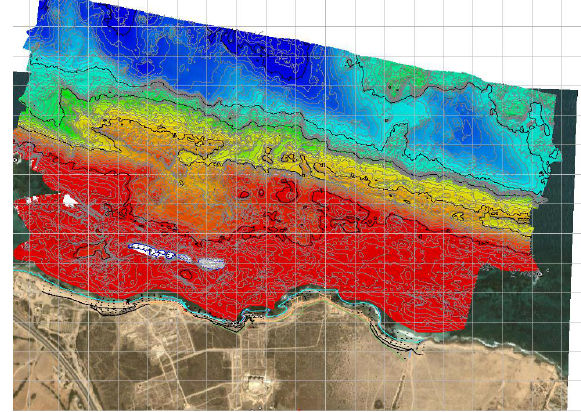
Figure 3. Results of the survey, showing contour curves The contour lines (figure 3.) in some of the offshore areas and along the shore lines show an irregular pattern which indicates rocky seabed. The contour lines in some of the deeper area with water greater than 6 m run parallel to shoreline indicating a sandy seabed. This pattern of o rocky shoreline with local sandy beaches and deeper sea areas with sandy seabed is very often seen along the North coast of Libya and along the NW coast of Egypt. This indicate that there is a transport of sand along in the coast, but that is taking place away from the coastline at deeper water.